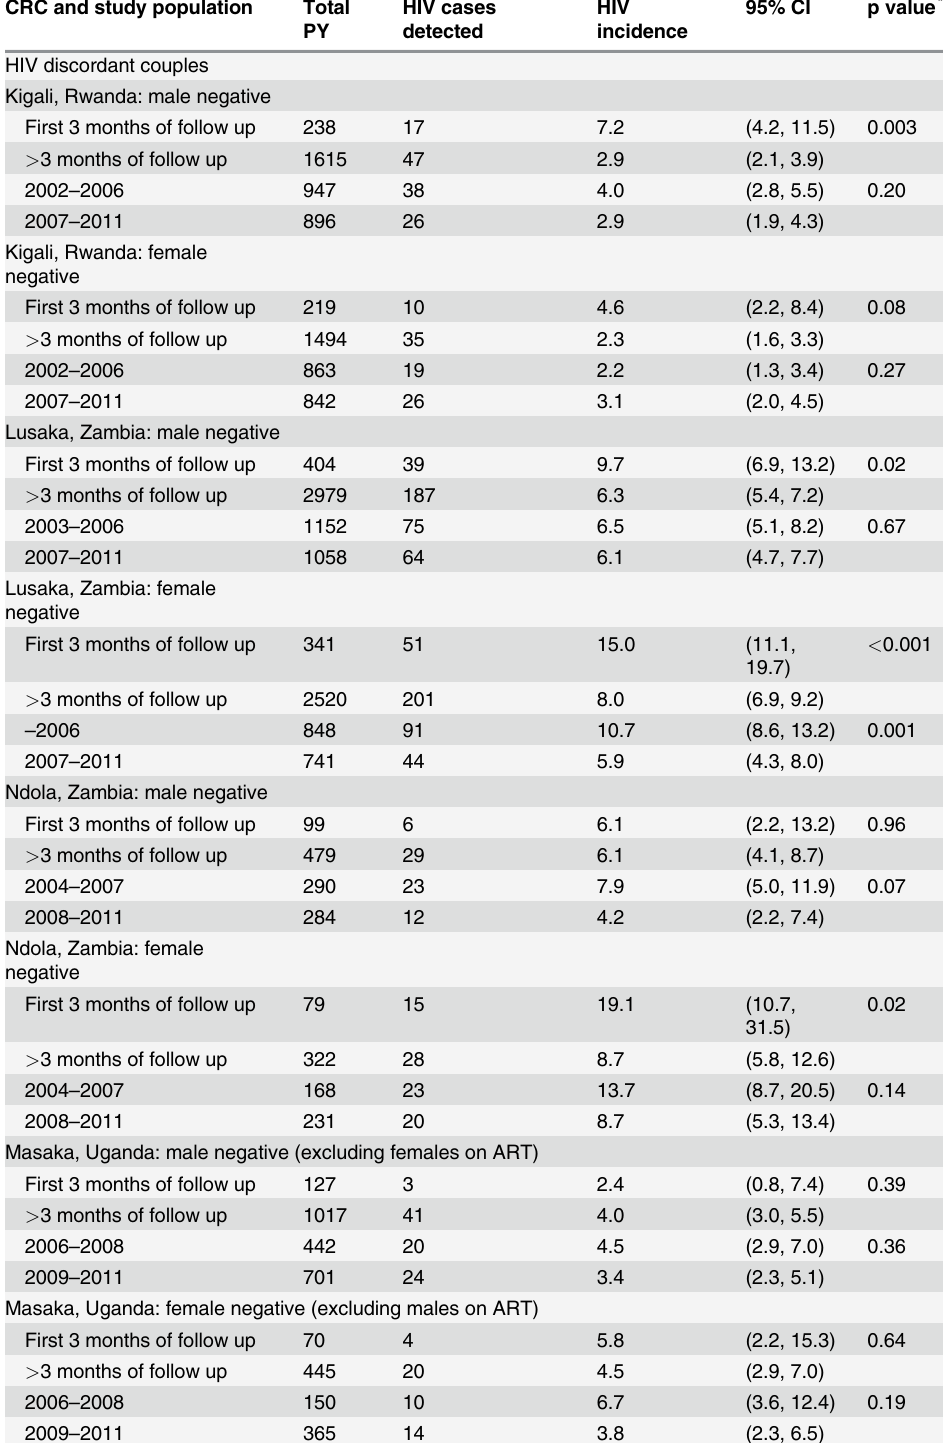
Table 3. HIV incidence strati fi ed by duration of time in study follow up, and (where data were available) by study